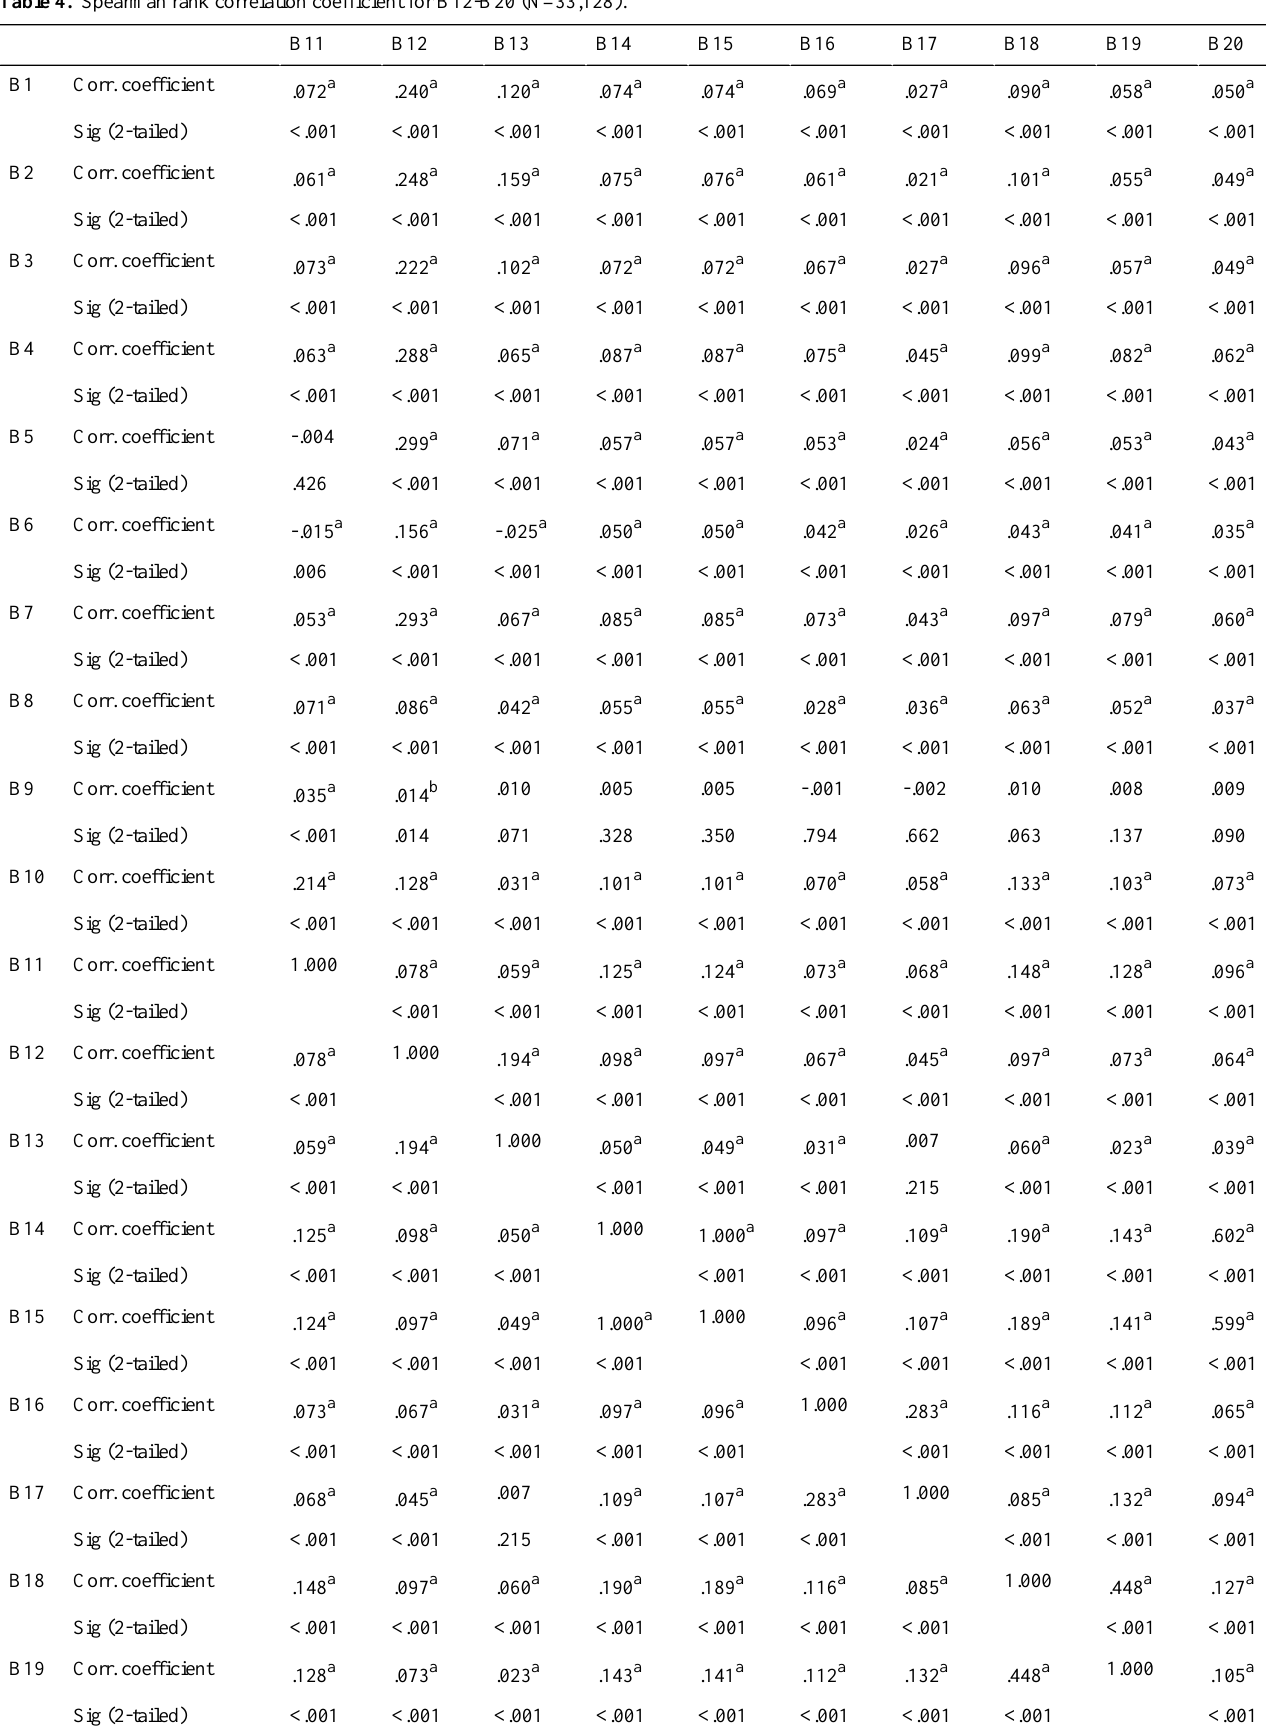
Table 4. Spearman rank correlation coefficient for B12-B20